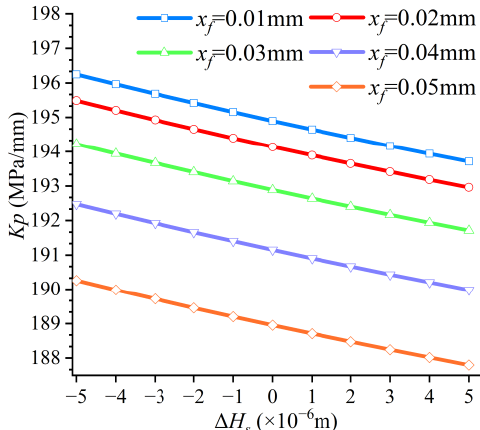
Figure 23. Drift of average pressure gain caused by installation error.